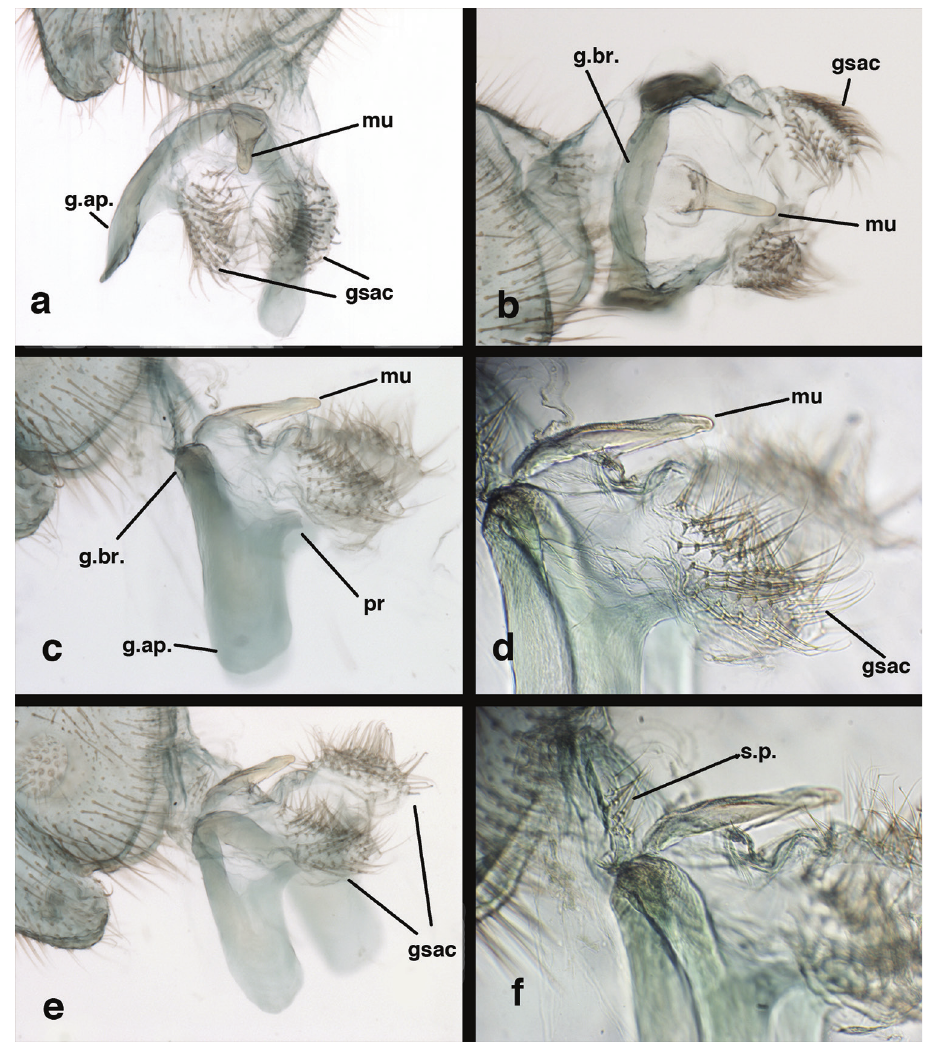
Figure 91. Ungla stangei Tauber, sp. n. Male genitalia (mature), ( a ) gonarcus, dorsal ( b ) gonarcus, frontal ( c–f ) gonarcus, lateral. gsac gonosaccus g.ap. gonarcal apodeme g.br. gonarcal bridge mu me- diuncus pr unarticulated process on frontal margin of gonarcal apodeme s.p. setose subanal plate (all: Peru, Andahuaylas, paratype, CAS). marked; maxillary palp with basal two segments pale, three distal segments black with articulations pale; labial palp with basal segment pale, distal two segments with black. Thorax green, with distinct longitudinal yellow stripe mesally; prothorax with transverse furrow in central region of segment, extending almost to lateral margins; setae mostly elongate, pale. Measurements: head width: 1.5–1.6 mm; ratio head width : eye width: 2.3–2.8 : 1; prothorax width: 1.0–1.1 mm, length: 0.8